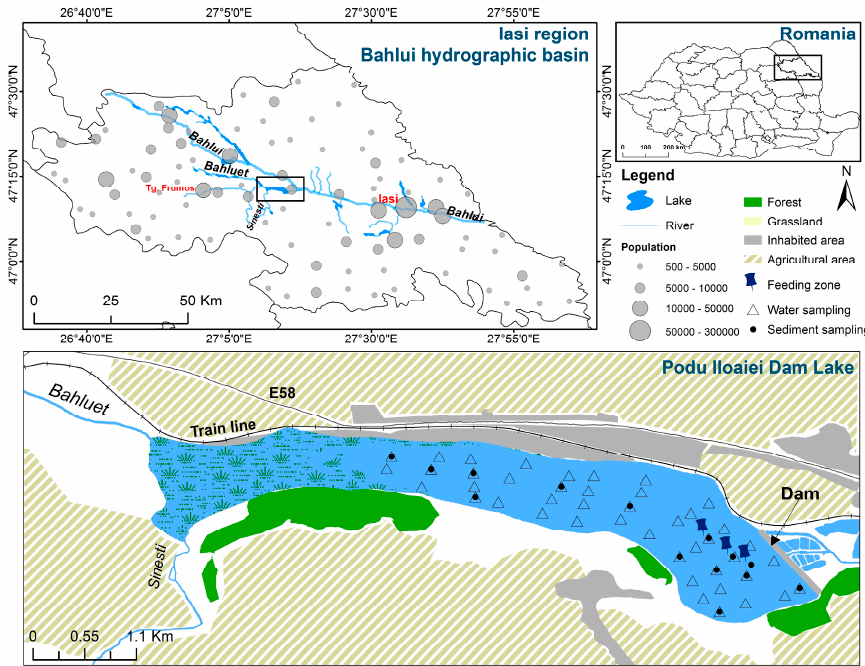
Figure 1. Location of the study area, water, and sediment sampling points.